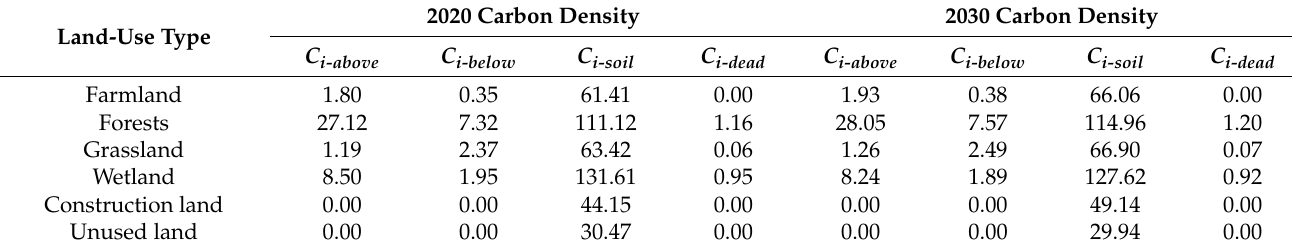
Table 1. Carbon density of different land-use types in DLB (unit: Mg · ha − 1 ).